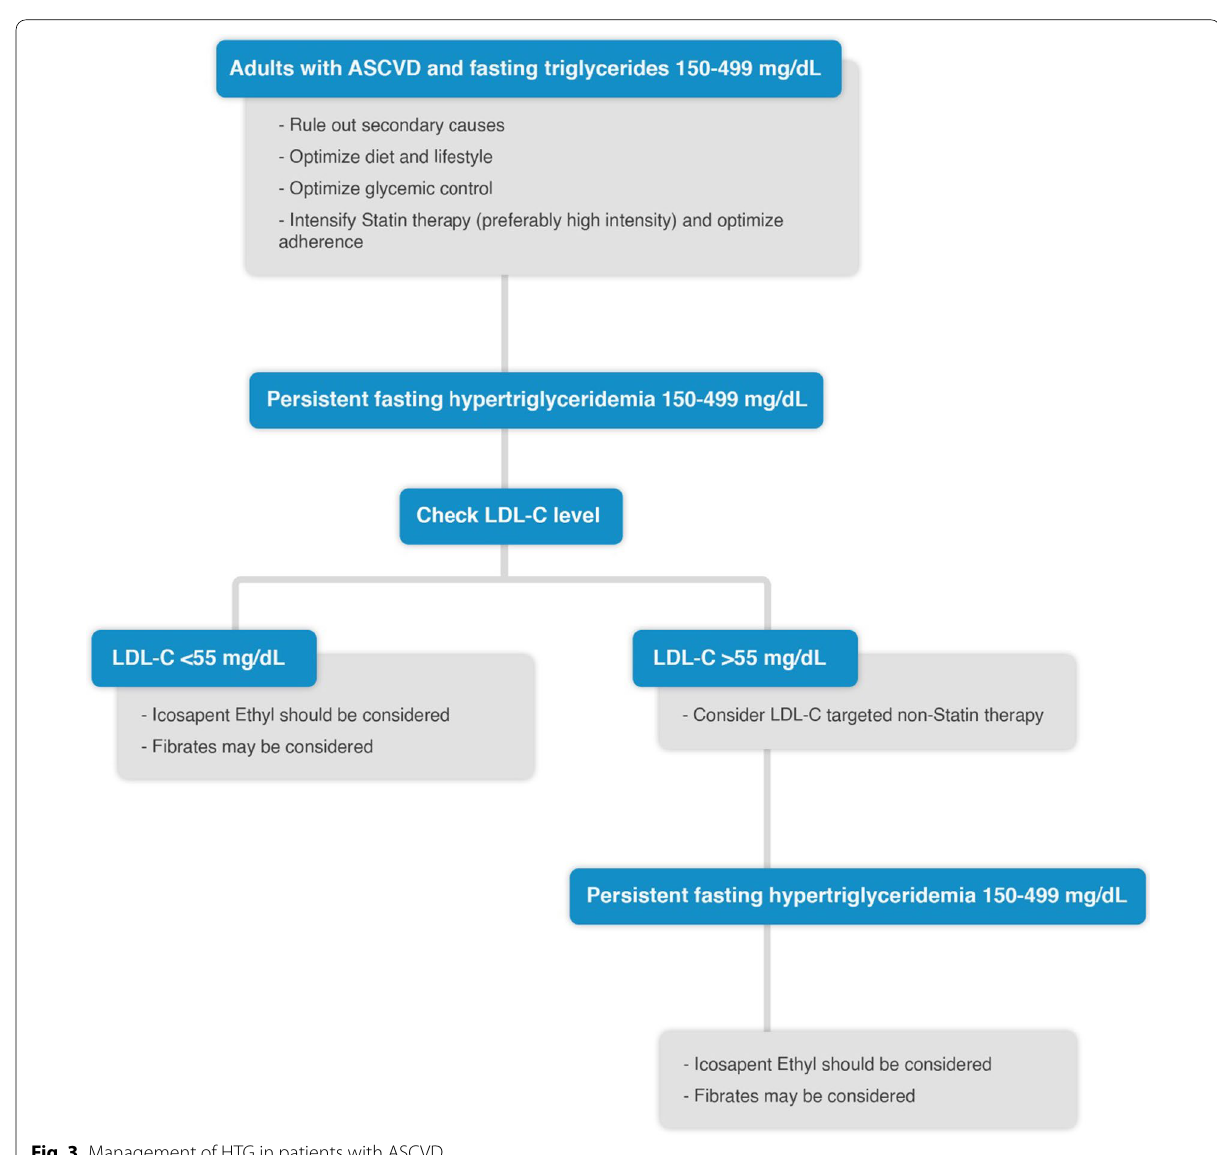
Fig. 3 Management of HTG in patients with